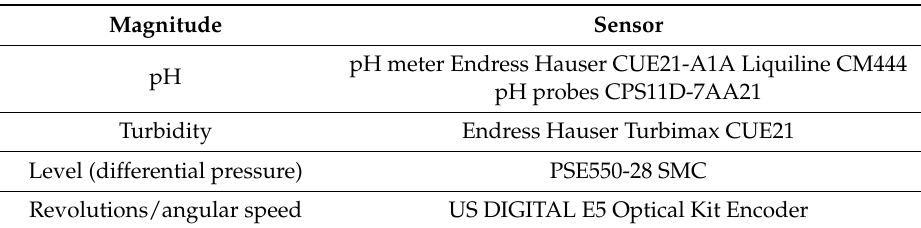
Table 1. Summary of magnitudes and sensors for the JT.